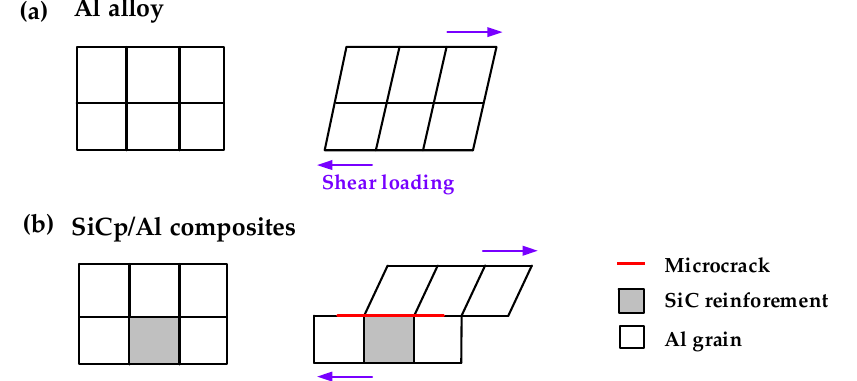
Figure 14. Deformation and failure mechanisms at microstructure scale of ( a ) Al alloy and ( b ) SiC p /Al composites when subjected to shear loading.